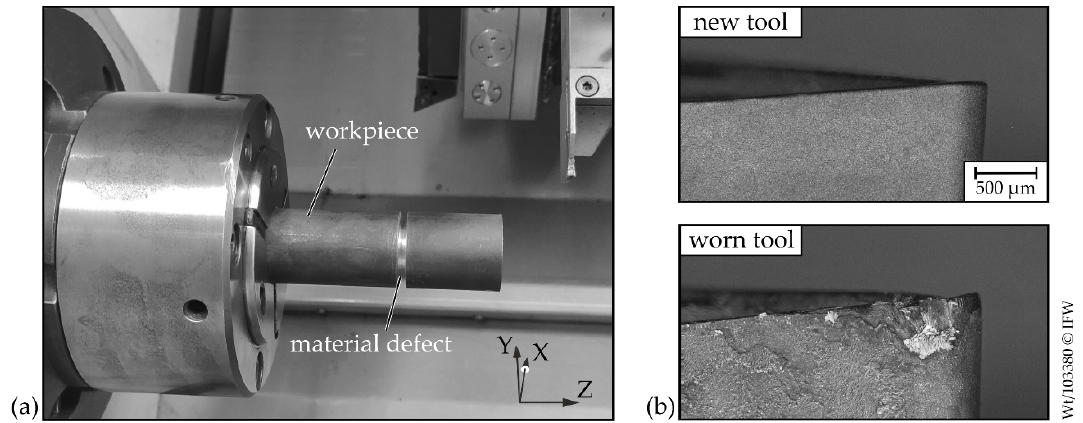
Figure 2. ( a ) Prepared workpiece and ( b ) presentation of the new and worn tool.